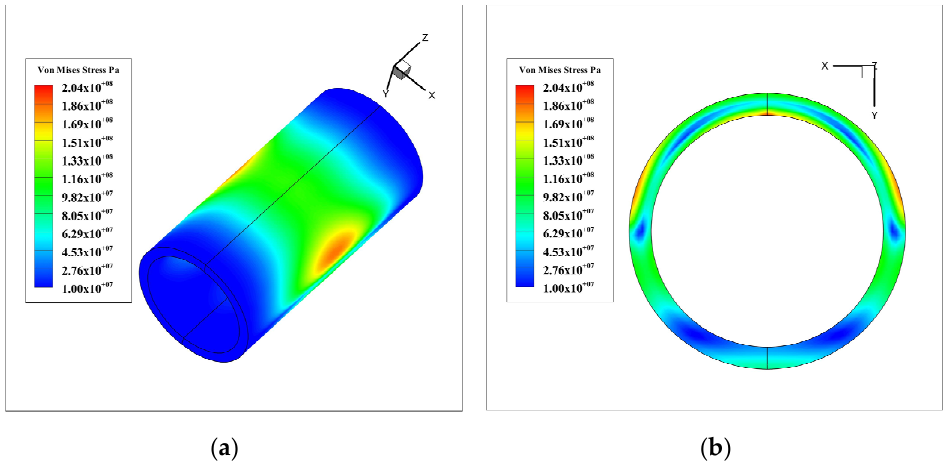
Figure 9. Thermal stress distribution of the tube. ( a ) Whole tube wall (z = 1:60); ( b ) Cross-wall of the tube (z = 0 m).